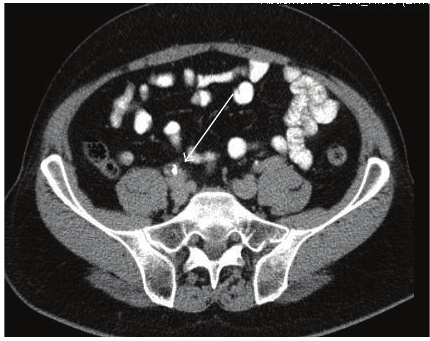
Figure 3: Thin-layer computed tomography demonstrating a small thickening of the right mid ureter.